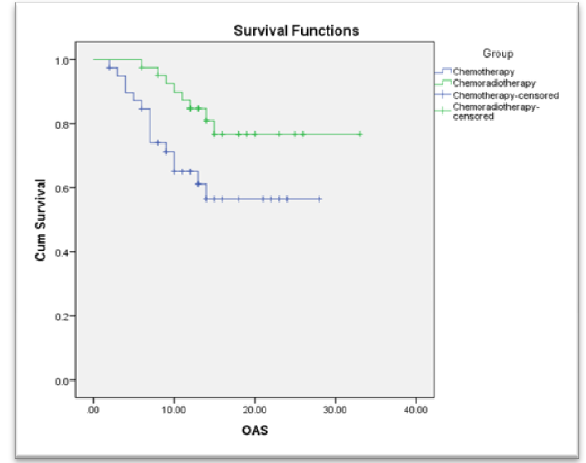
Figure 2: The Kaplan–Meier curve for overall survival (OS)